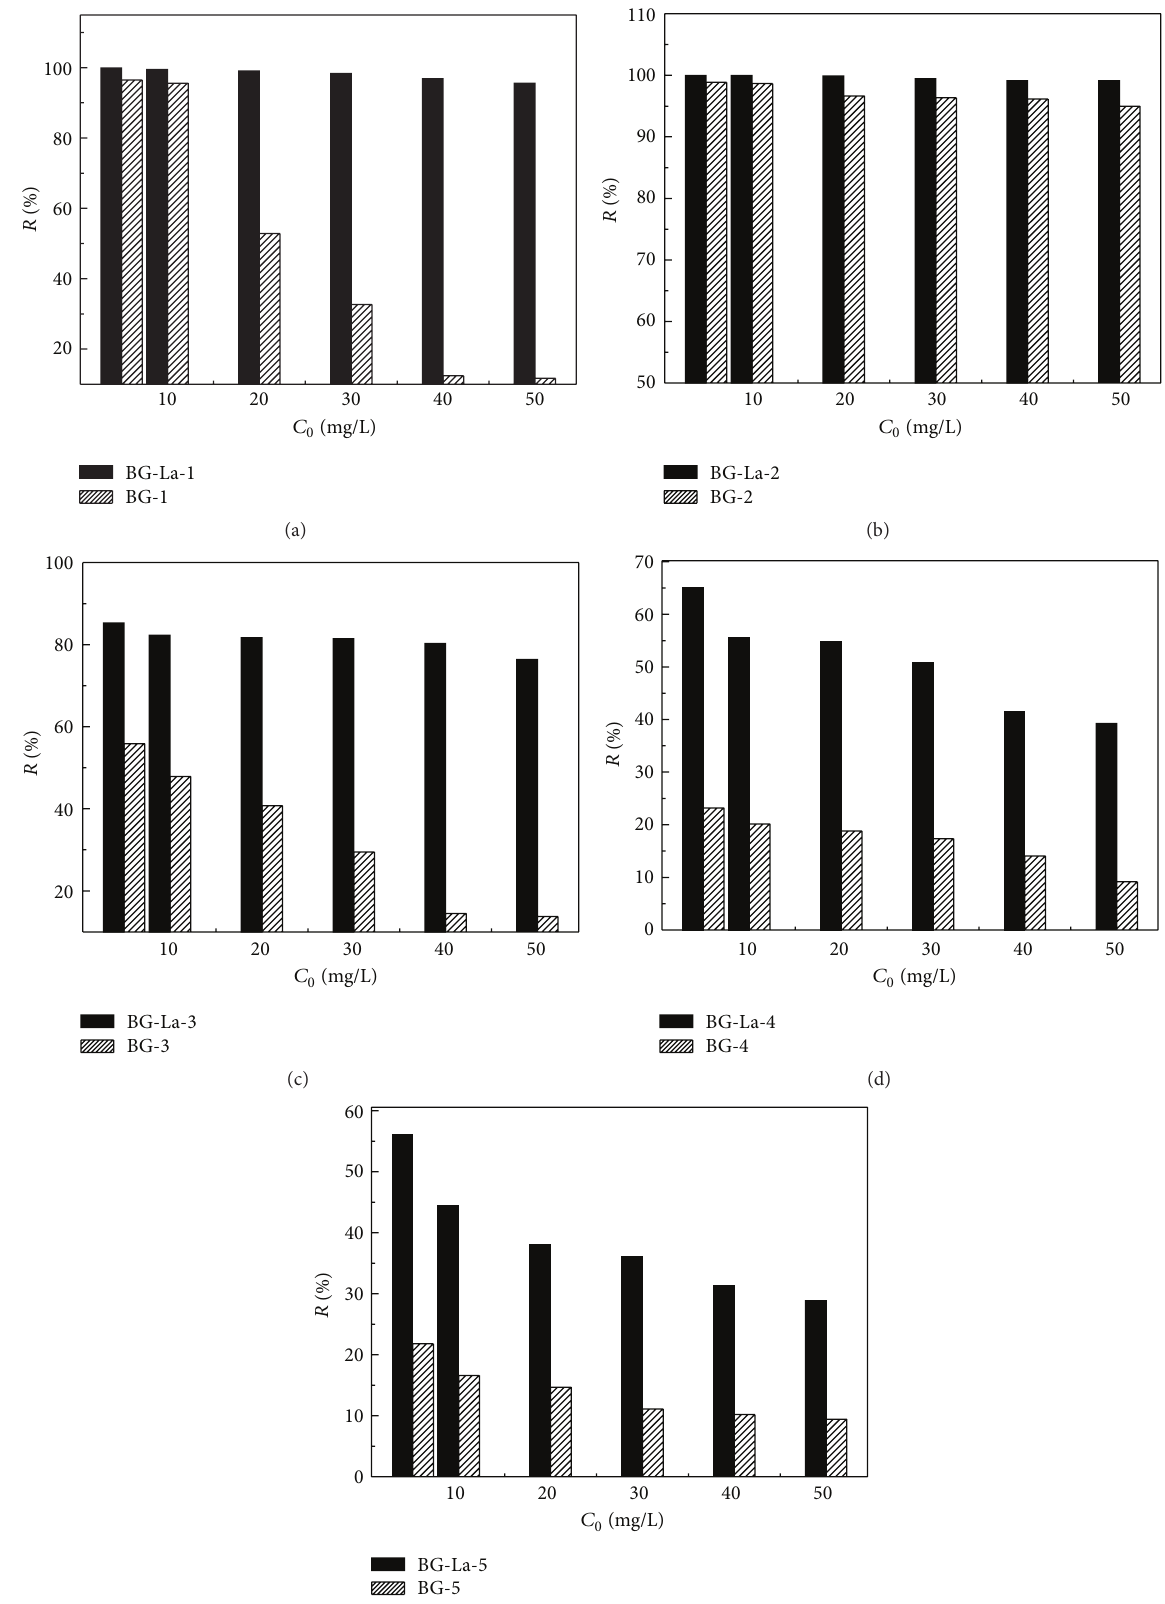
Figure 7: Effect of initial MB concentrations on BG-La-1 ∼ 5 and BG-1 ∼